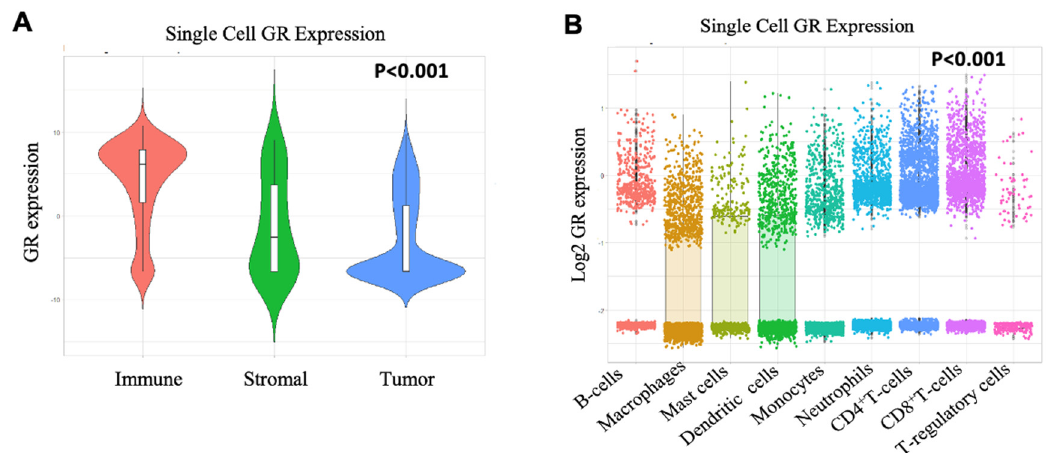
Figure 2. Single cell sequencing data of primary breast cancer. ( A ) GSE75688 shows that immune cells have higher GR expression than tumor and stromal cells. Data compiled from GSE cited was used to perform one-way ANOVA across all cell subsets. The p value is for the F statistic within ANOVA. ( B ) GSE114725 shows that CD8 + T-cells have higher GR expression than other immune cell subsets. Data compiled from GSE cited was used to perform one-way ANOVA across immune cell subsets. The p value is for the F statistic within ANOVA. Bonferroni correction was used to compare CD8 + T-cells to other immune cell subsets with higher average mean in post-hoc analysis.